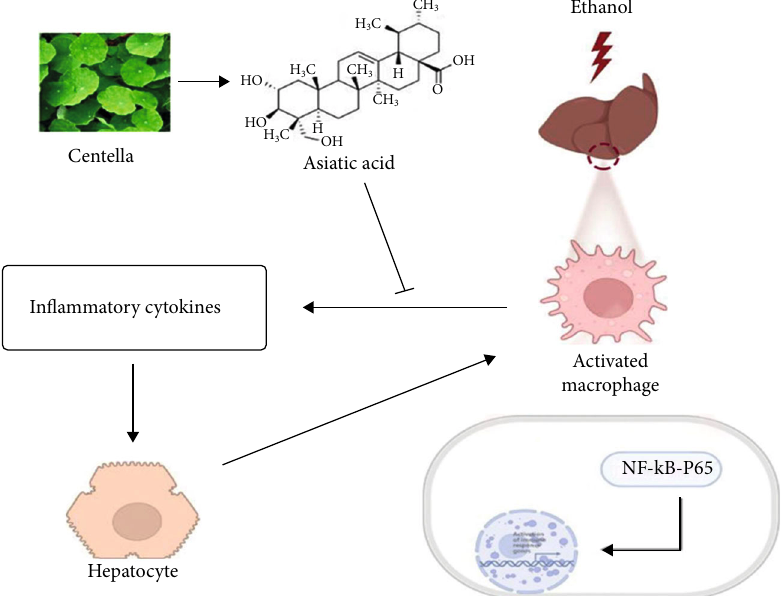
Figure 9: Mechanism of asiatic acid alleviating alcoholic steatohepatitis through the NF- κ B signaling